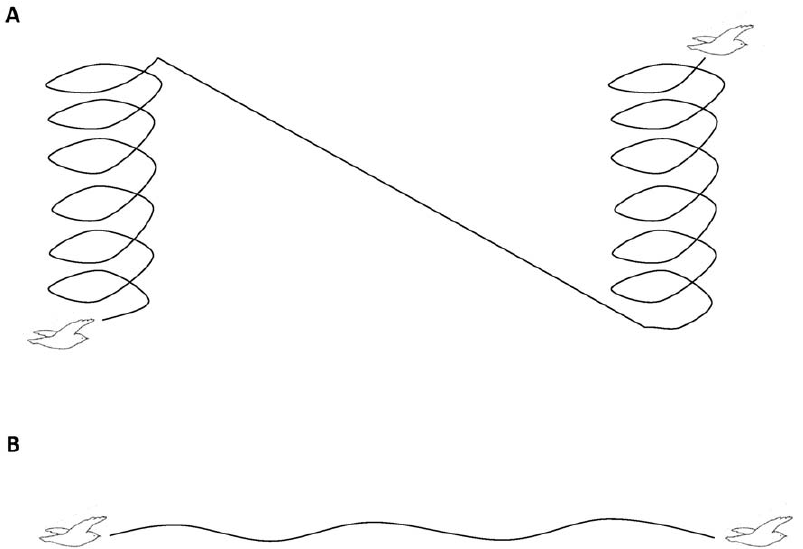
Figure 1. Sketch of European bee-eater flight modes. (A) Soaring-gliding flight employs updrafts created by the heating of the ground for gaining potential energy during soaring by circling over the rising air. During gliding the bird sinks in the air and progresses horizontally. (B) Flap- glide flight that is composed of sequences of short alternating flapping and gliding phases.